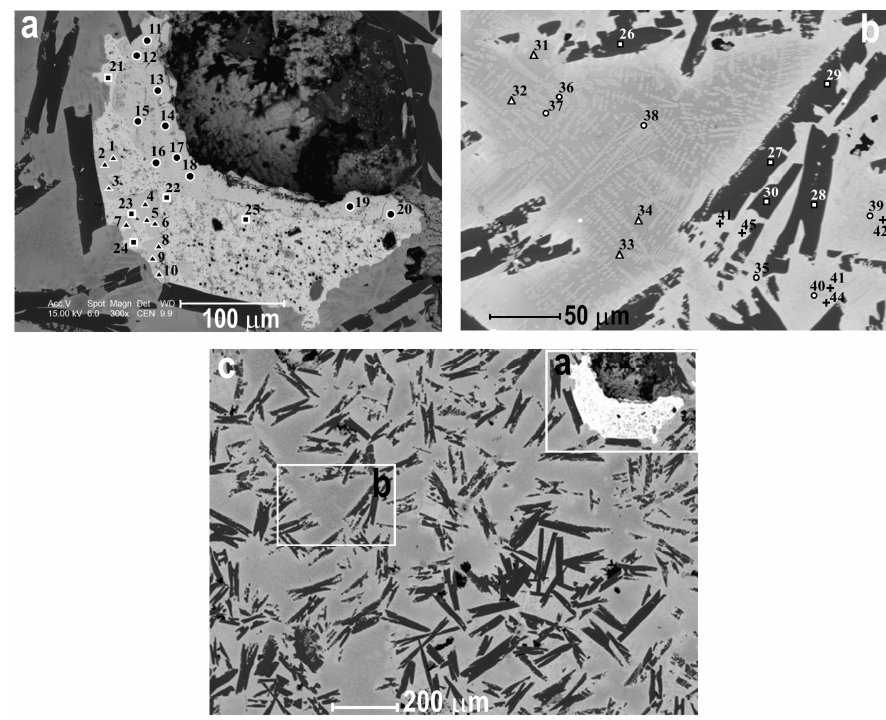
Figure 5. SEM images of slag samples ( a ) galena, litharge and metallic lead, ( b ) glass, melilite, lead analogue of larnite. ( c ) location of area a and b. Points no.—site of EPMA microanalysis specified in Tables 2 and 3. Black triangles—galena, black circles—litharge, black squares—metallic lead, white squares—melilite, white circles—lead analogue of larnite, crosses—glass. Table 2. Electronprobe micoanalyses of phases-building aggregates of relict ore minerals after a smelting process (in wt.%). Phase Analysis No. Pb